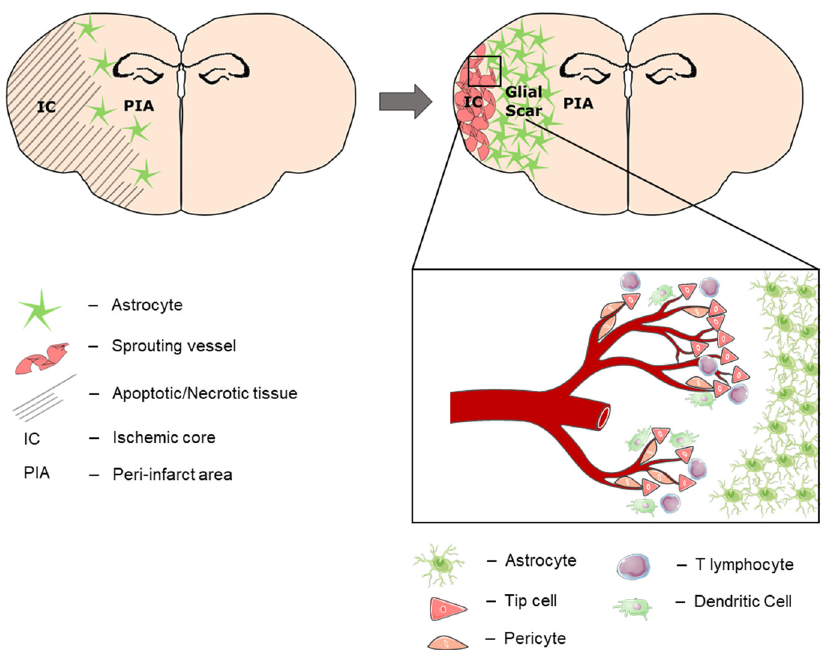
Figure 7. Tissue compartmentalization 28 days after stroke. During post-stroke recovery, the astroglial scar separates the affected hemisphere into the peri-infarcted area (PIA) and the ischemic core (IC). Over time, neural regeneration occurs within the PIA, which expands towards the cortical periphery as the IC shrinks. At the subpial cortex within the IC, another region of immune cell infiltration and neovascularization (IC-ANV) occurs in the late stage of post-stroke recovery.